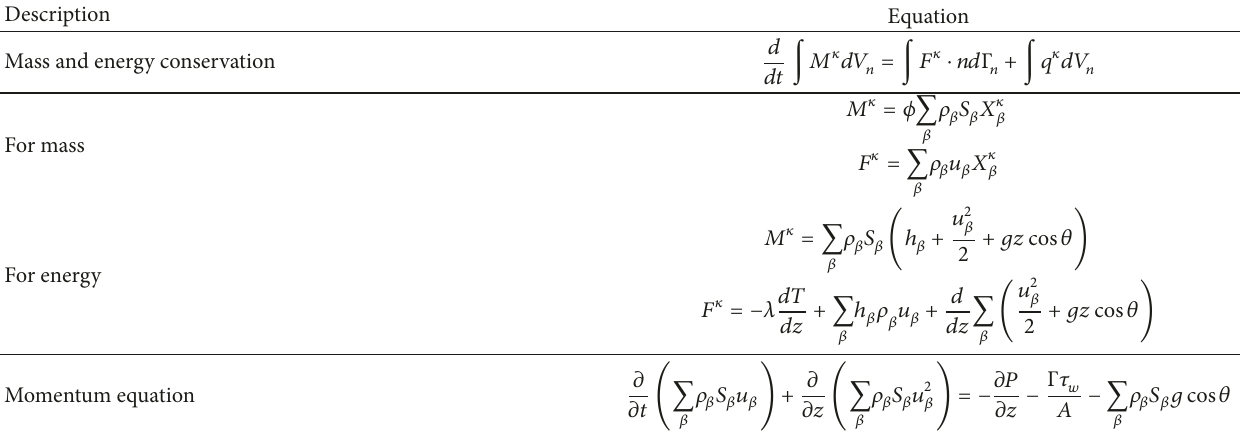
Table 4: The governing equations for numerical